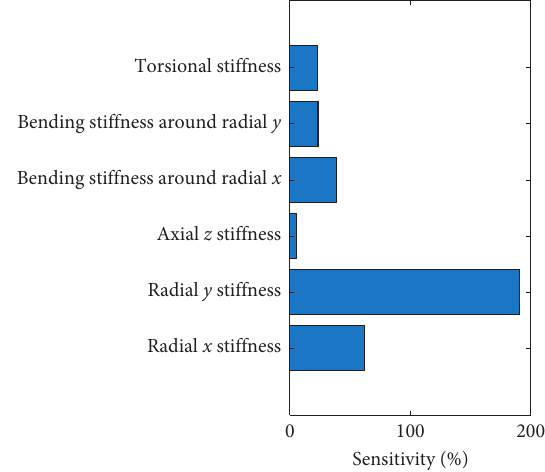
Figure 9: Sensitivity analysis of bushing Table 9: Six degree-of-freedom of bushing stiffnesses.